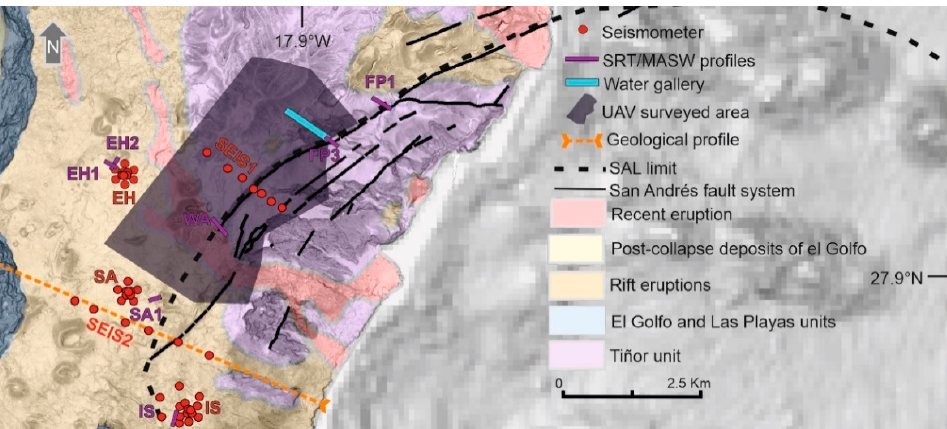
Figure 2. Location of the 2020 and 2021 geophysical and UAV survey sites plotted on the geological map (for legend, see Figure 1). The survey sites are EH—El Hierro, SA—San Andrés, IS—Isora, FP—Fault Plane, and WA—West Andres sites.